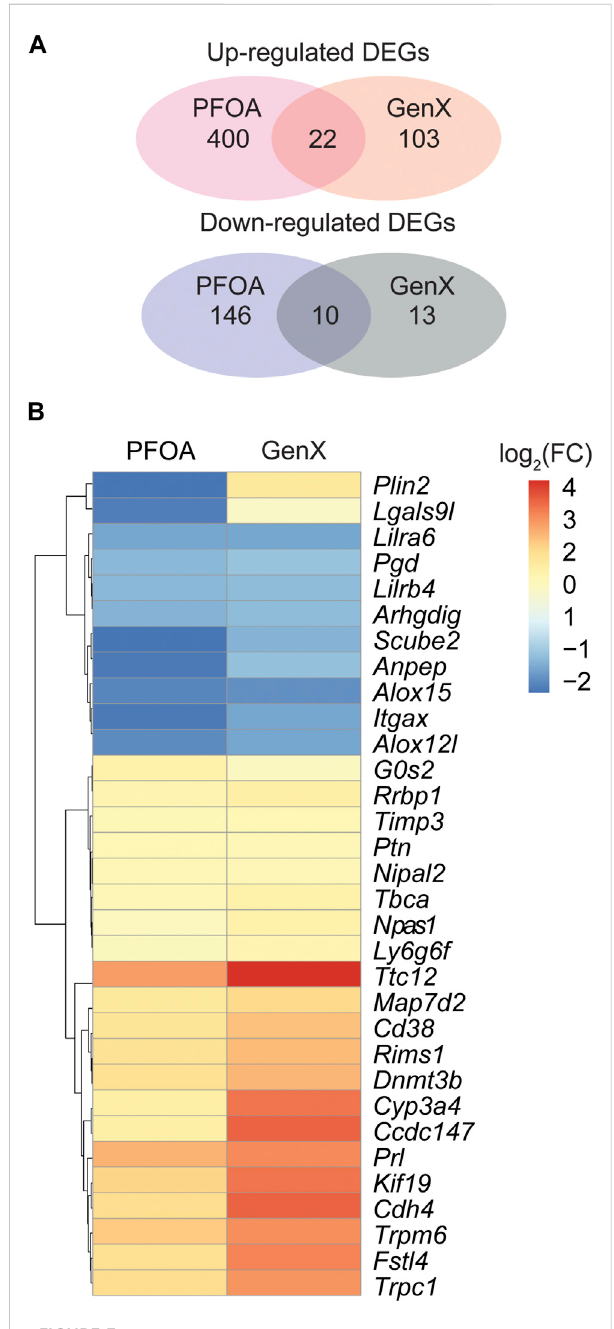
FIGURE 3 Differentially expressed genes in the PFOA and GenX-treated groups. (A) Venn diagram showing the overlap of upregulated and downregulated DEGs among the two treatment groups. (B) Hierarchical clustering of 32 overlapped DEGs identi fi ed between the PFOA and GenX treatment groups. Red represents upregulation, and blue indicates